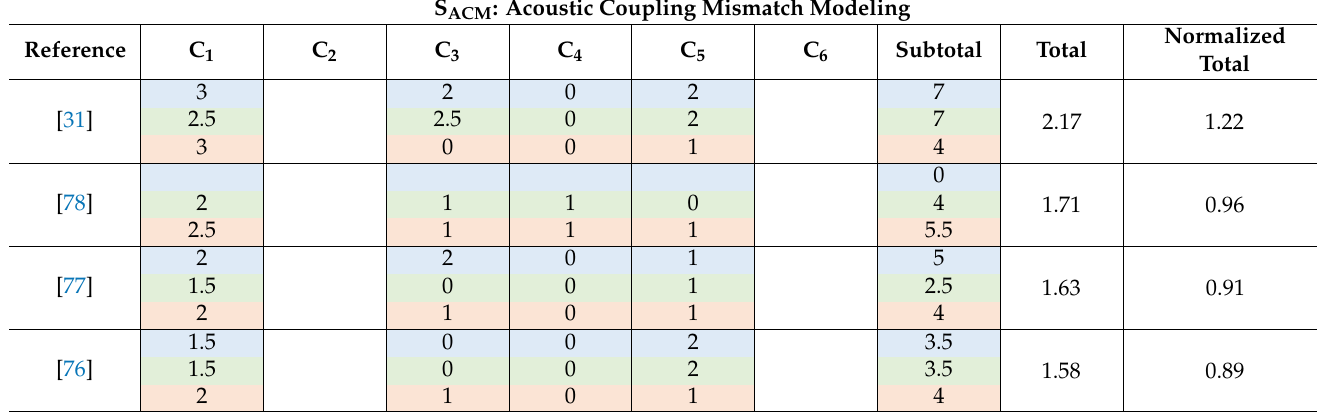
Table A5. Analytical ratings for all studies included in S ACM . The color in the table rows indicates the category of experiments as follows: numerical experiments , experiments with phantoms , and experiments with humans in vivo . The columns corresponding to evaluation criteria that were not applicable to this subgroup were left empty.